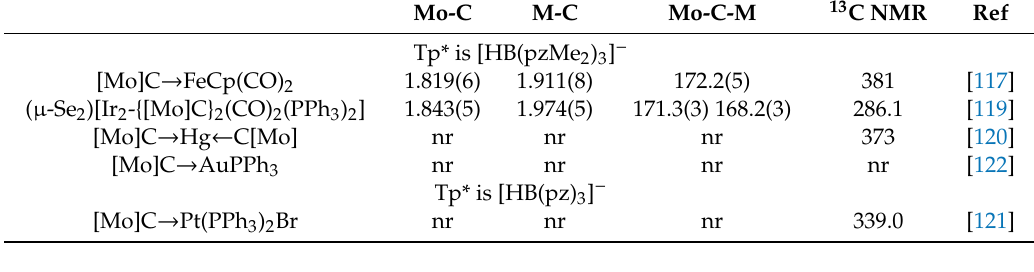
Figure 28. The [Mo] − C core. Tp* = tris(3,5-dimethylpyrazolyl)borate, [HB(pzMe 2 ) 3 ] − or [HB(pz) 3 ] − . Table 16. Compounds with [Mo] − C core with Tp* = [HB(pzMe 2 ) 3 ] − or [HB(pz) 3 ] − .